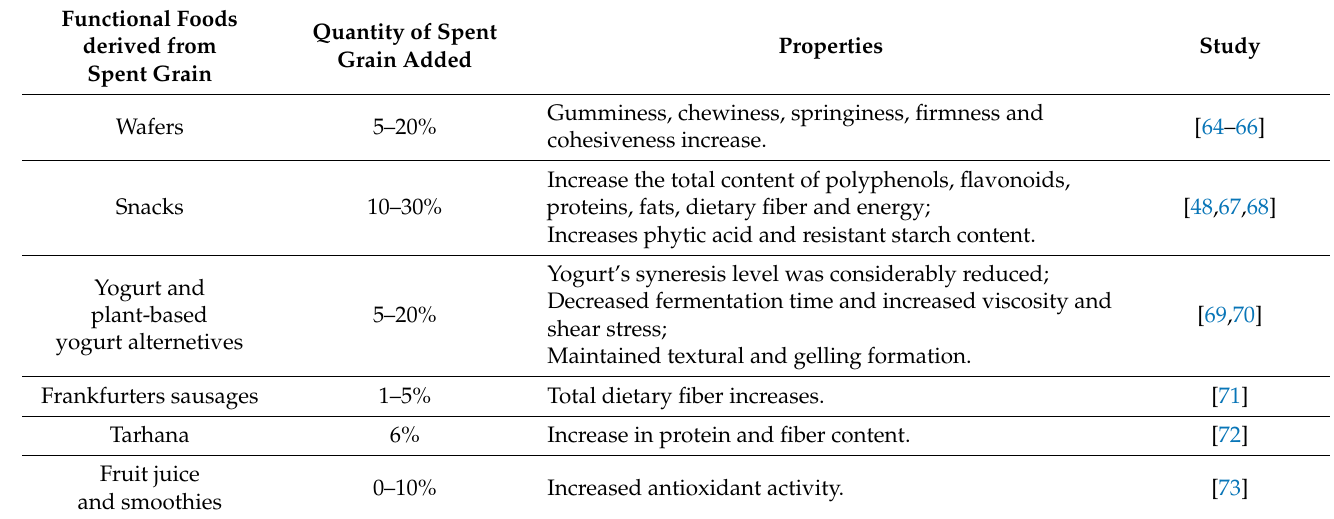
Table 2. Characteristics of functional foods derived from spent